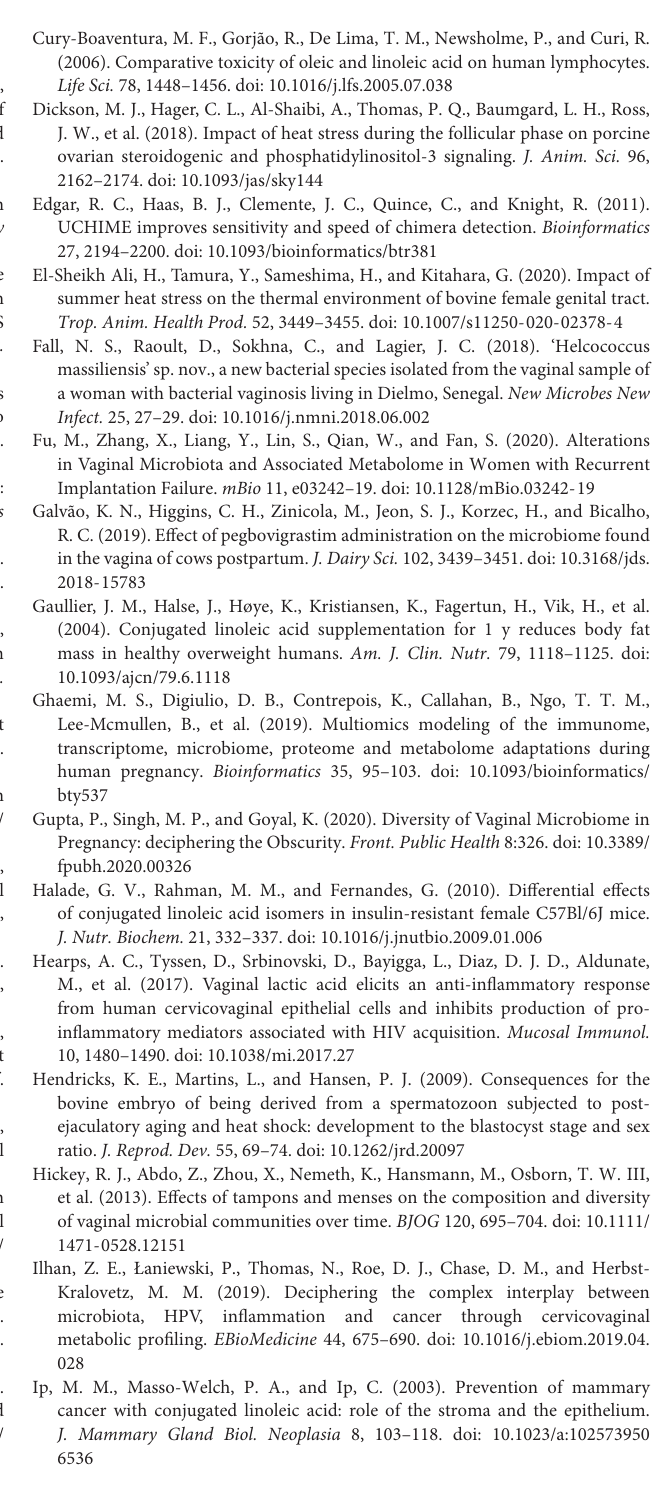
Supplementary Table 2 | The relative concentrations of all metabolites. HS1–HS8 indicate the eight individual animals in the Heat group, and CONT1–CONT8 indicate the eight individual animals in the Control